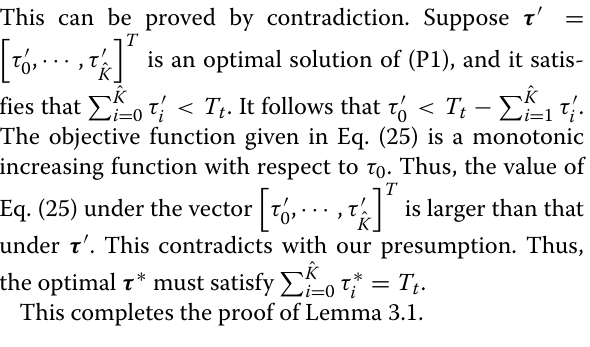
protocol, HTT and AHC, in terms of channel